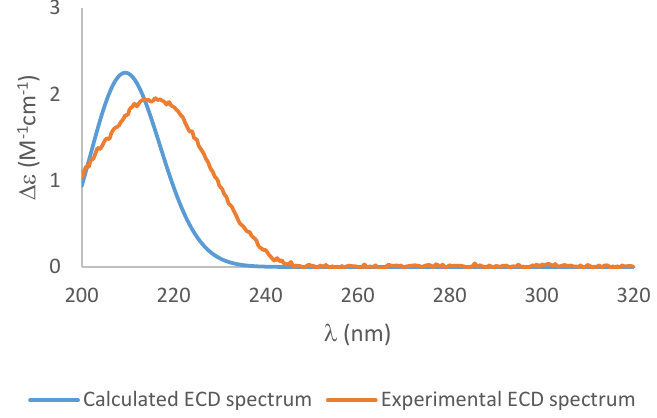
Figure 5. The experimental ECD spectrum ( orange ), and the calculated ECD spectrum of 1 ( blue ) (blue shift = −6).